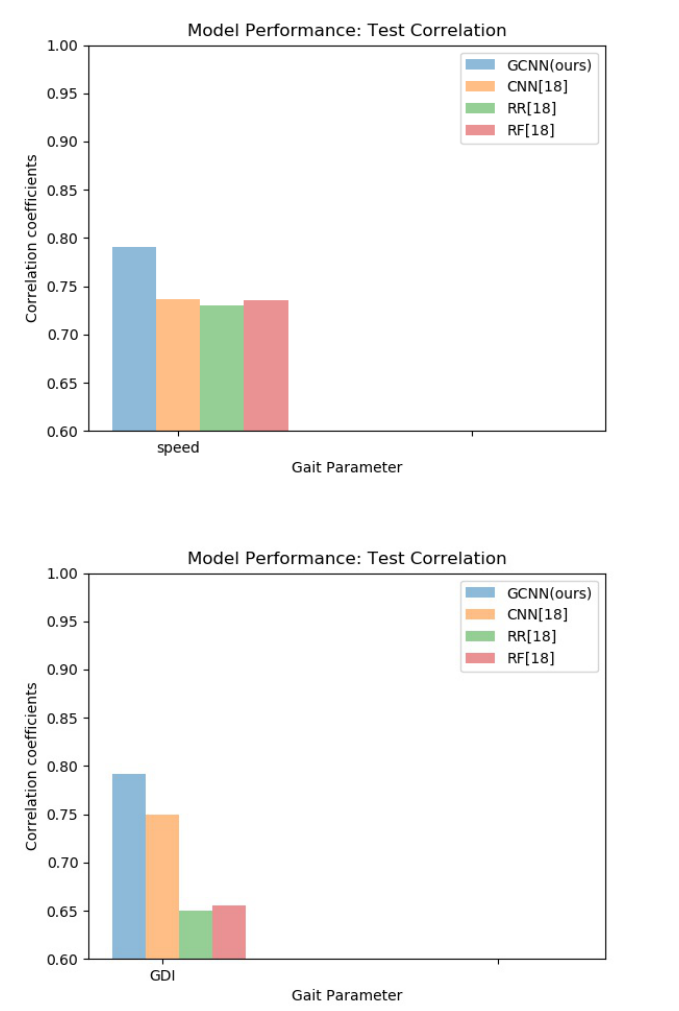
Figure 5. Comparison prediction accuracy of the proposed graph convolutional network with the previous methods on speed and gait deviation index (GDI) gait parameters. The three methods our proposed graph convolutional neural network (GCNN) compared are: convolutional neural network (CNN), ridge regression (RR), and random forest (RF). After training our model on video inputs, we have evaluated on test data. The correlation values shows how the predicted metric values are related with the ground truth that are prepared from optical motion sensor